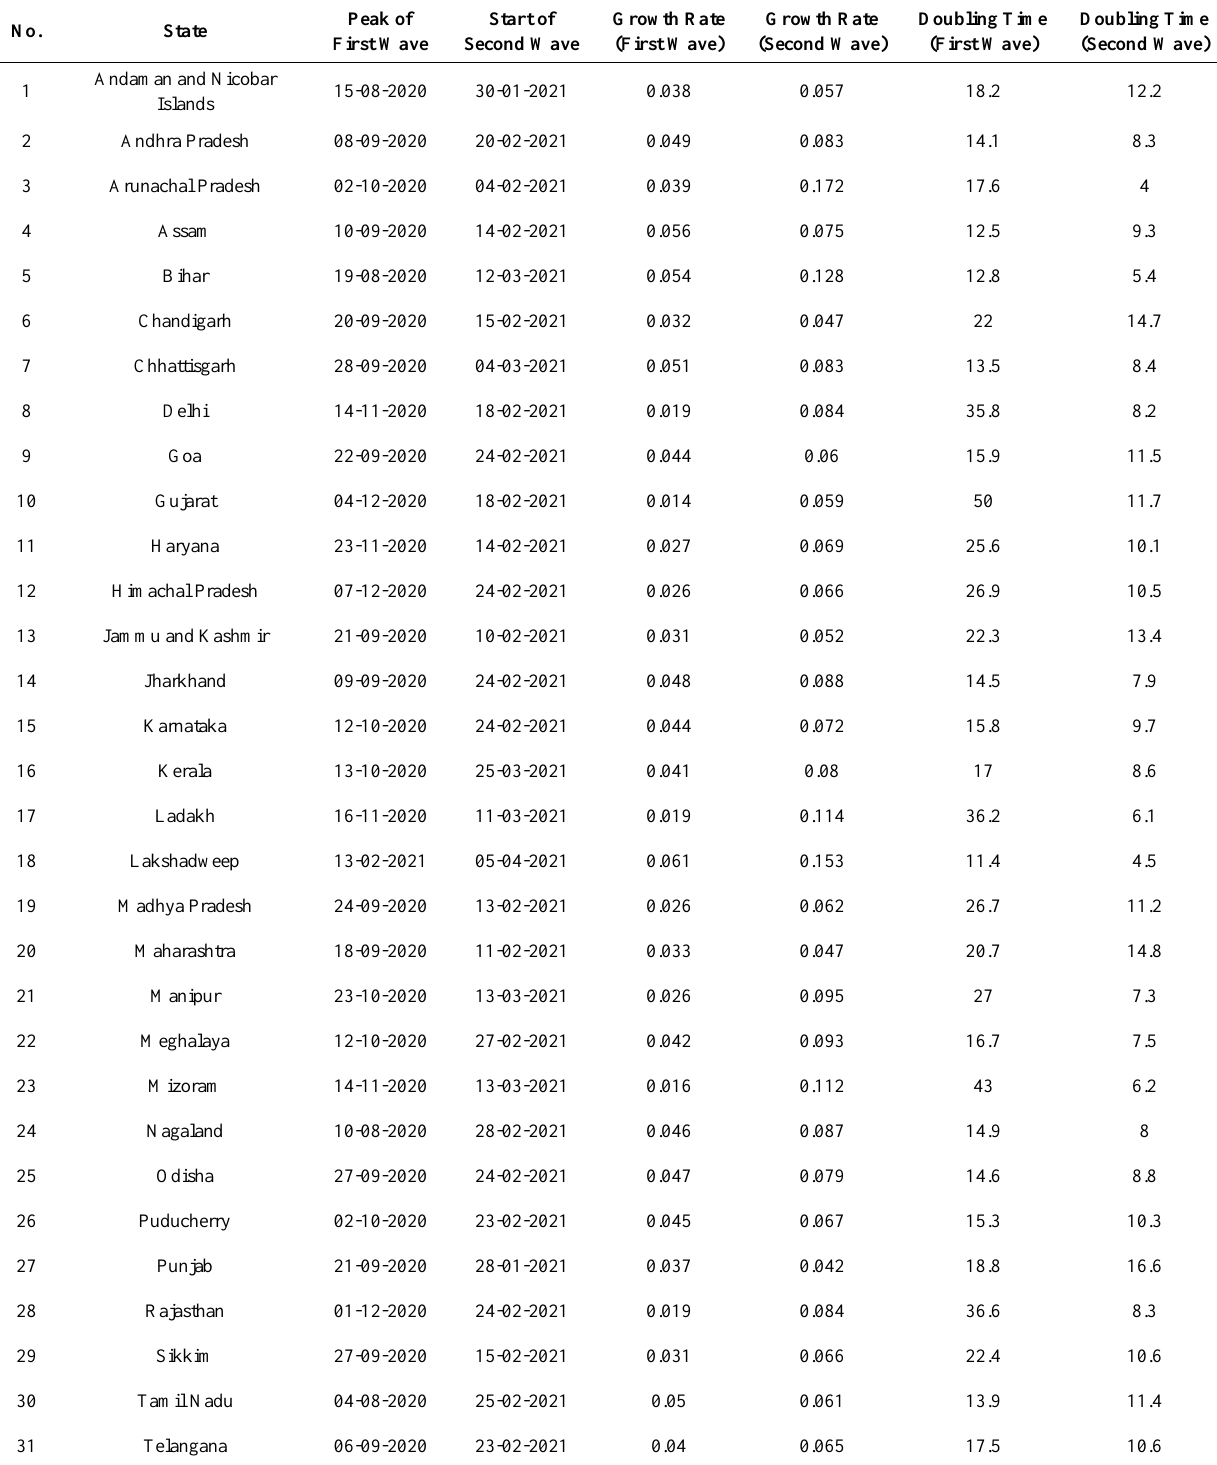
The estimated time-dependent reproduction number ( R t ) for India was above the threshold of one (Figure 2.a). Figure 2.b and 2.c illustrate the three-dimensional visualization of the time-dependent reproduction number across different states and districts of Maharashtra, respectively. The findings of the analysis suggest that the R(t) is well above the threshold of one in many states and requires closer monitoring. This also suggests that the second wave of COVID-19 infections in India is still in the exponential phase of the epidemic. Table 3. The epidemiological indicators of the first wave and second wave across different states of India